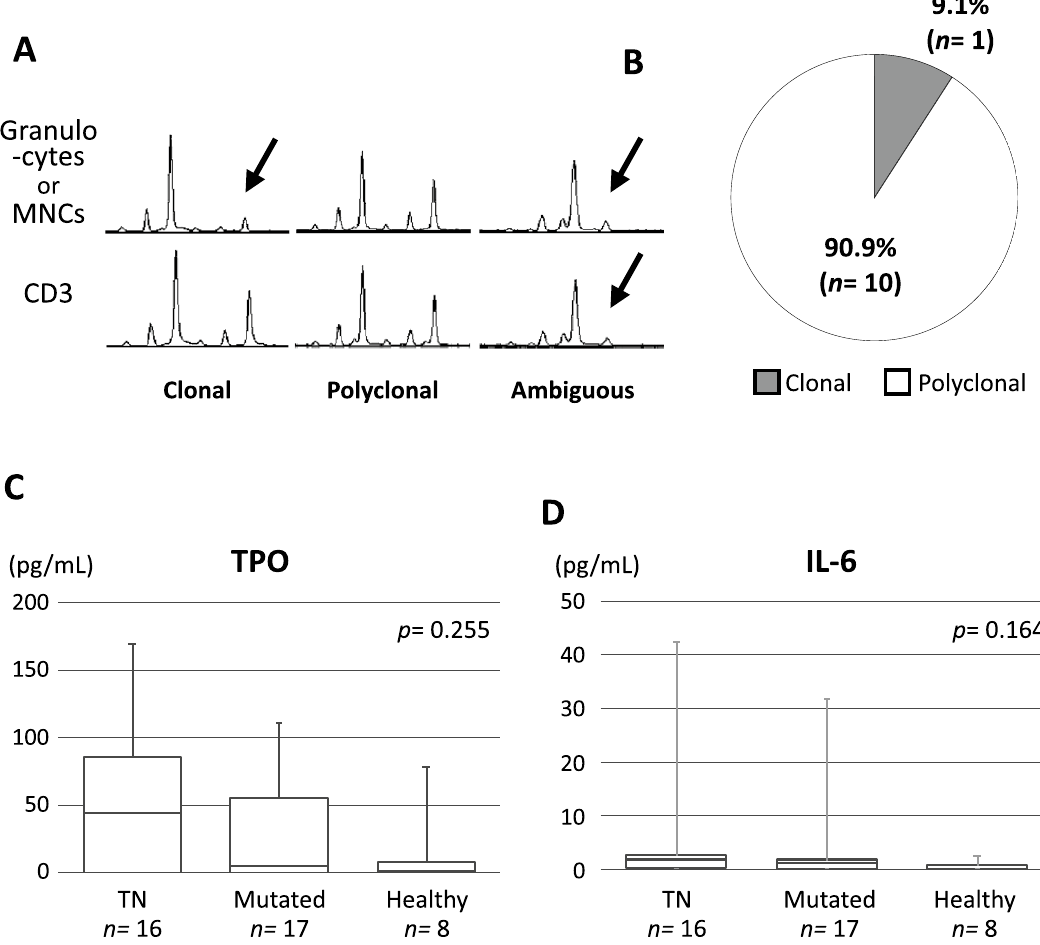
Figure 4. Polyclonal hematopoiesis in the TN-ET patients harboring comparable serum levels of cytokines for megakaryopoiesis. ( A ) Typical profiles of capillary electrophoresis of HpaII-digested gDNA from granulocytes (n = 10) or MNCs (n = 5) and CD3-positive cells. Two HpaII-resistant peaks representing maternal and paternal alleles in polyclonal hematopoiesis. One of these alleles becomes HpaII-sensitive in granulocytes, representing clonal hematopoiesis (arrow). ( B ) A pie chart presenting the frequencies of clonal and polyclonal hematopoiesis judged by the HUMARA assay in TN-ET. Four of 15 patients who exhibited ambiguous patterns in the HUMARA assay ( A ) were excluded from the analysis. Comparison of TPO ( C ) and IL-6 ( D ) concentrations in the serum among the patients with TN-ET, patients with ET harboring driver mutations, and healthy